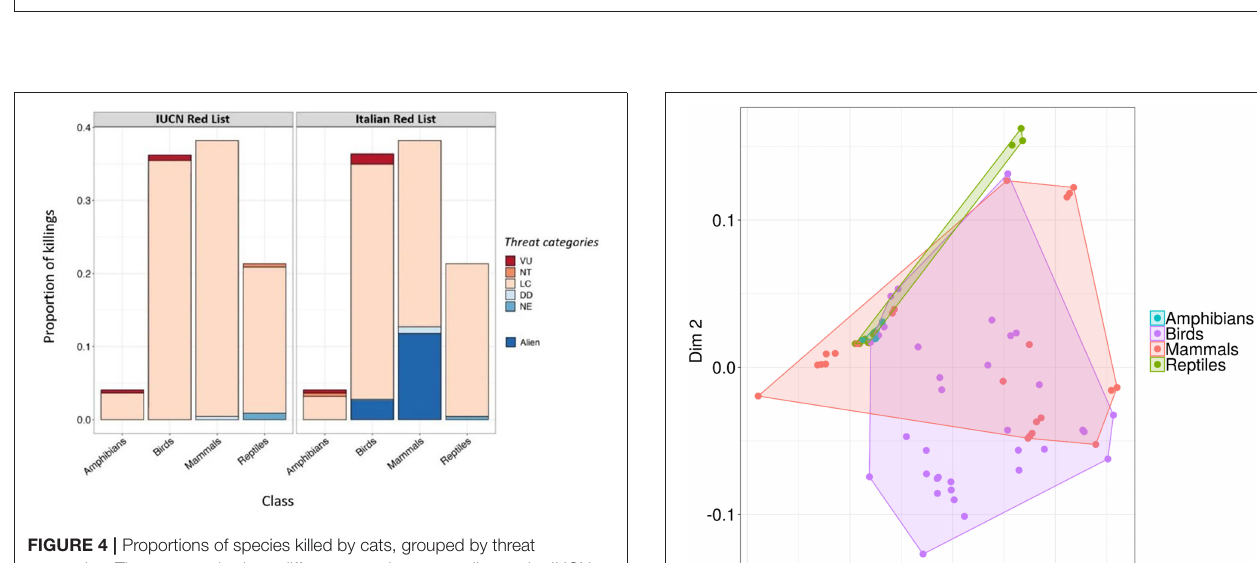
latastei and Passer italiae , are classified as “Vulnerable” and one reptile, Elaphe quatuorlineata , is classified as “Near Threatened” by the IUCN Red List. In contrast, when grouping species according to the Italian Red List, a further “Near Threatened” amphibian ( Triturus carnifex ) and a “Vulnerable” bird ( Pyrrhula pyrrhula ) were also included.